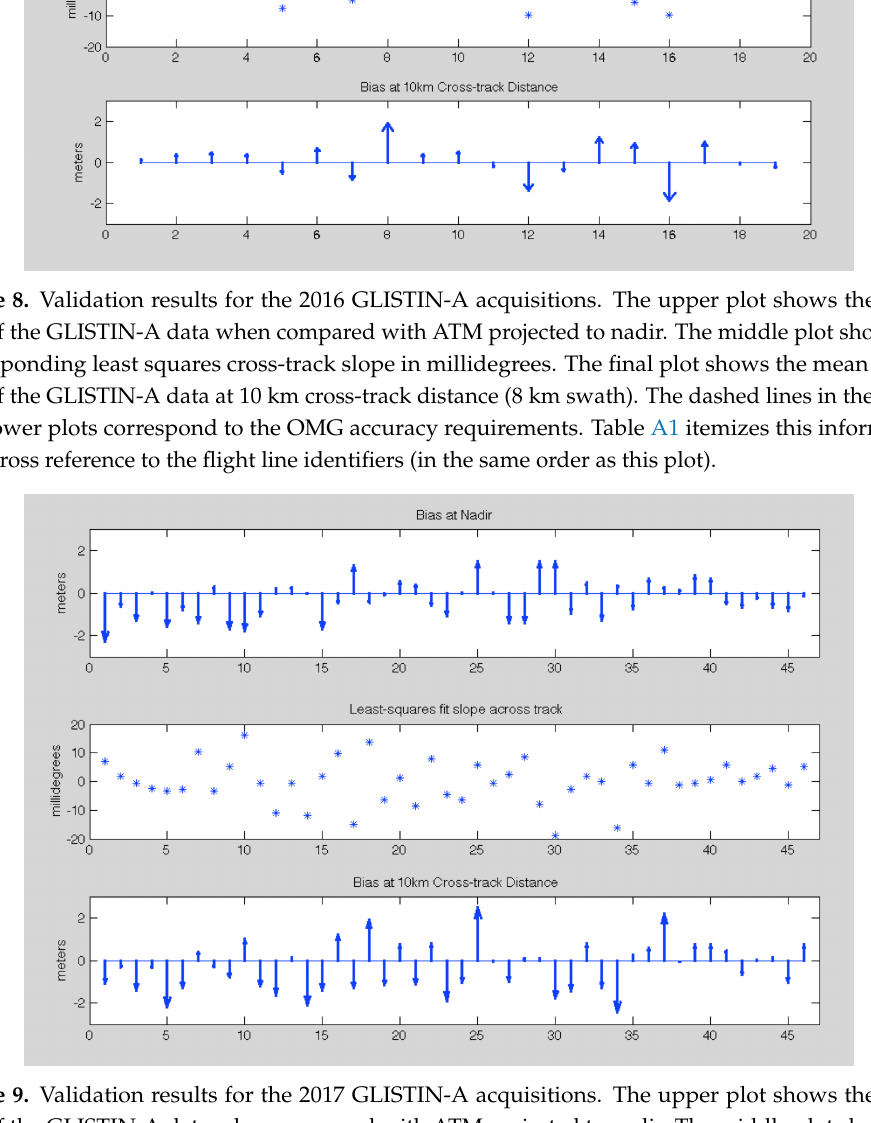
Figure 9. Validation results for the 2017 GLISTIN-A acquisitions. The upper plot shows the mean bias of the GLISTIN-A data when compared with ATM projected to nadir. The middle plot shows the corresponding least squares cross-track slope in millidegrees. The final plot shows the mean height bias of the GLISTIN-A data at 10 km cross-track distance (8 km swath). The dashed lines in the upper and lower plots correspond to the OMG accuracy requirements. Table A2 itemizes this information with cross reference to the flight line identifiers (in the same order as this